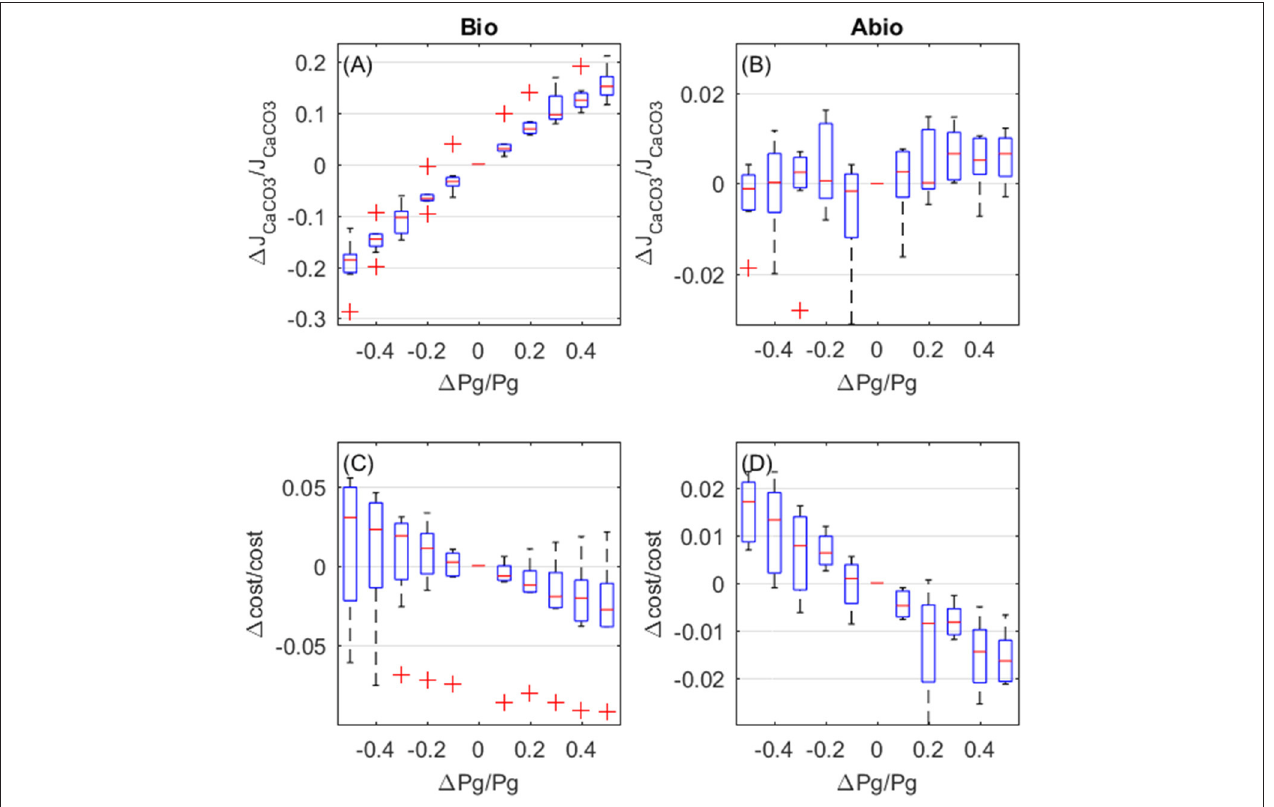
FIGURE 6 | Biologically-mediated (A,C) and abiotic (B,D) effects of photosynthesis, fractional change in calcification rates (top panels) and calcification costs (bottom panels). X and y-axis values are indicative of fractional change. Each boxplot represents all light setups.